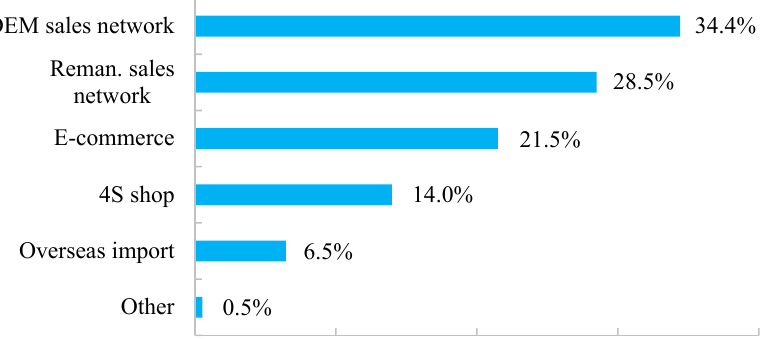
Figure 4. Purchase channels of remanufactured products.